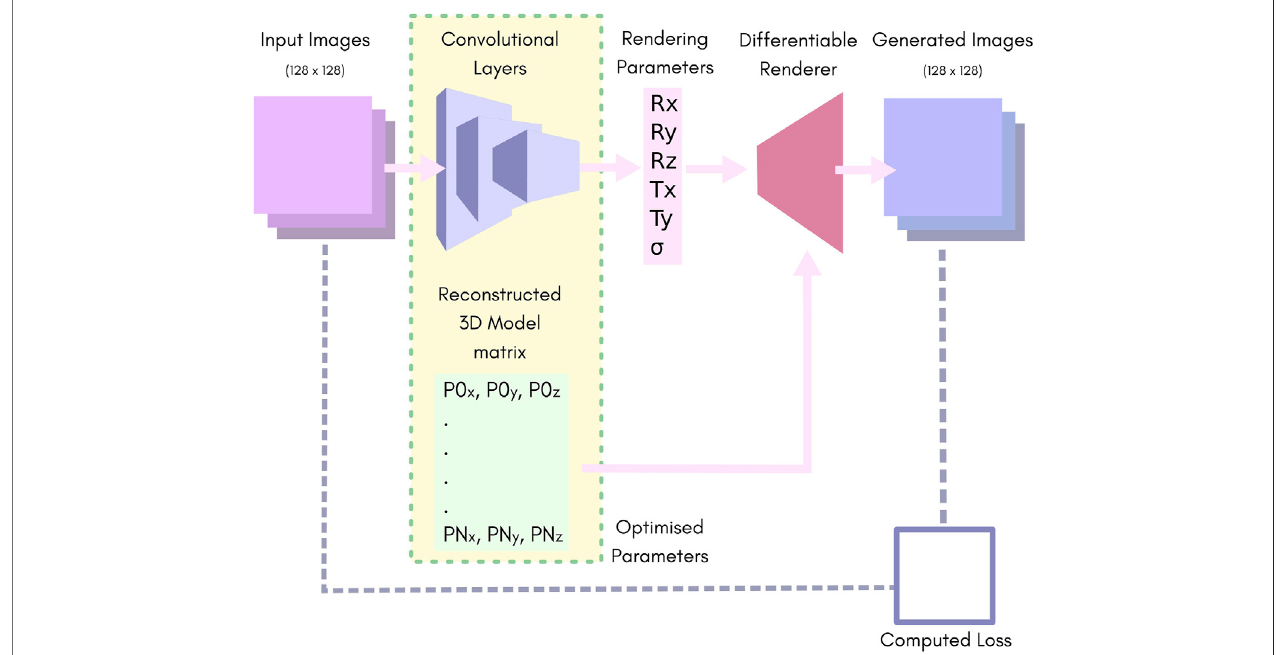
FIGURE1| Anoverviewofournetwork.Batchesofimagesofsize128 × 128pixelsarefedtotheconvolutionlayers,whichreducethebatchdownto6parameters. These are passed to the rendering pipeline along with the 3D reconstruction matrix to produce a batch of output images. The rendering parameters Rx, Ry and Rz represent the rotation in “ Angle-Axis ” form. Tx and Ty represent translation in the X, Y plane. S represents the predicted output-sigma. The 3D reconstruction matrix contains a list of vertices representing the predicted